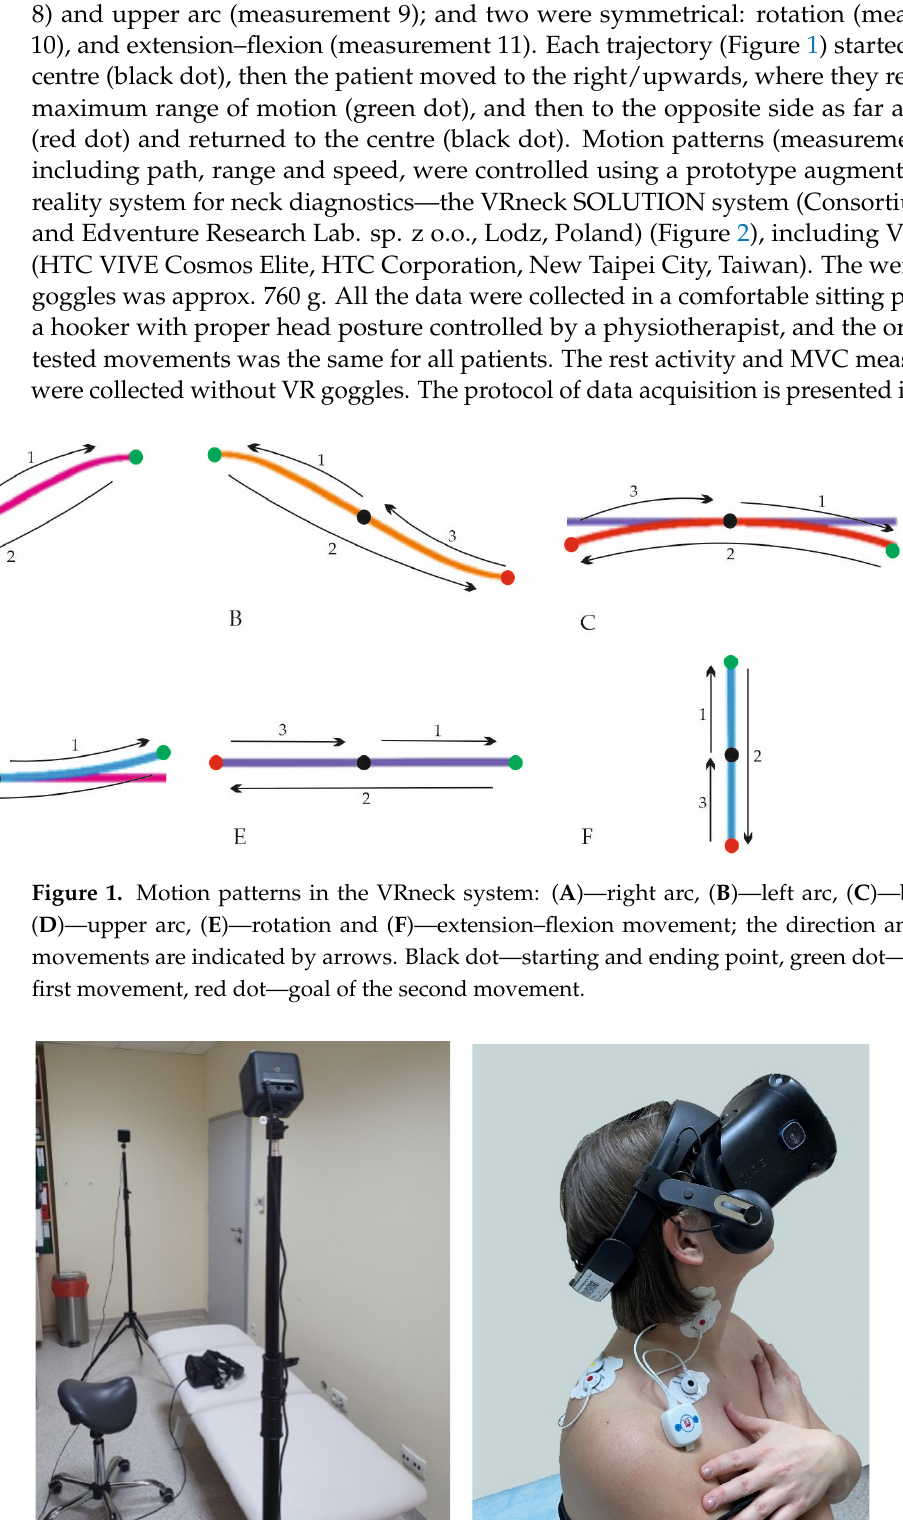
Figure 3. Study protocol. 2.3. EMG Data Analysis The Protocol of EMG data analysis is presented in Figure 4. Firstly, for each trial, unprocessed signals from SCM and UT muscles were visually inspected in time and fre- quency domains and detrended. EMG signals were then band-passed at 25–450 Hz, with a fourth-order Bu tt erworth fi lter. Next, EMG signals were full-wave recti fi ed and smoothed by using the RMS algorithm with a 50 ms window. Subsequently, EMG signals from all trials were normalized as the percentage of maximal voluntary contraction (% MVC). MVC was the maximum peak for the signal from measurement 2 (left upper